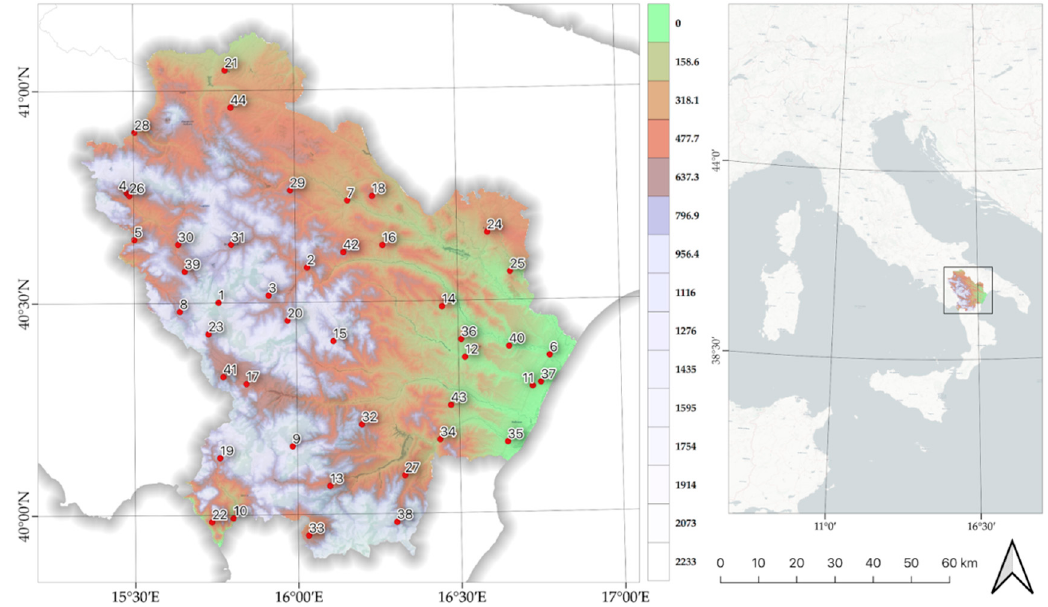
Figure 1. Geographical location of the used meteorological ground observation stations. In the right panel, blue is for water and white is for land.